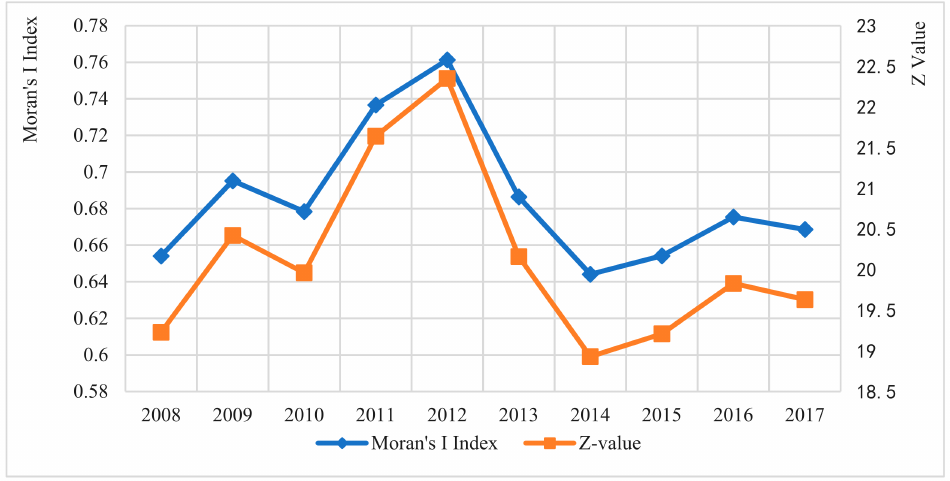
Figure 5. Change in Moran’s I Index, Z-value for the green development,